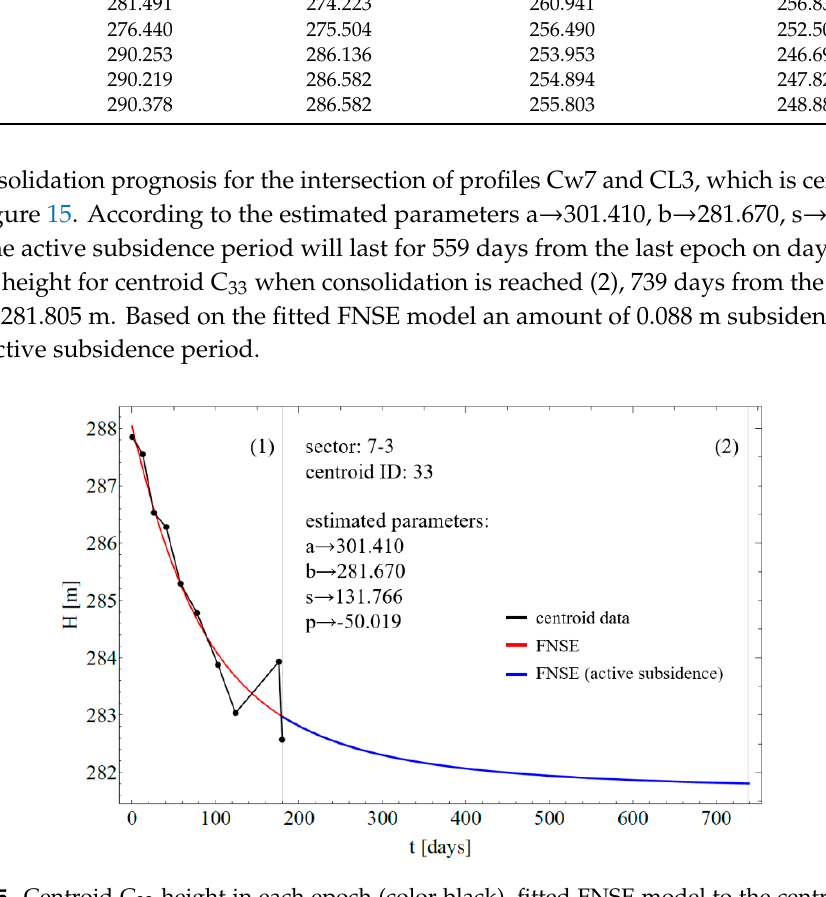
prognosis with the FNSE model, and in the final subsidence prognosis.